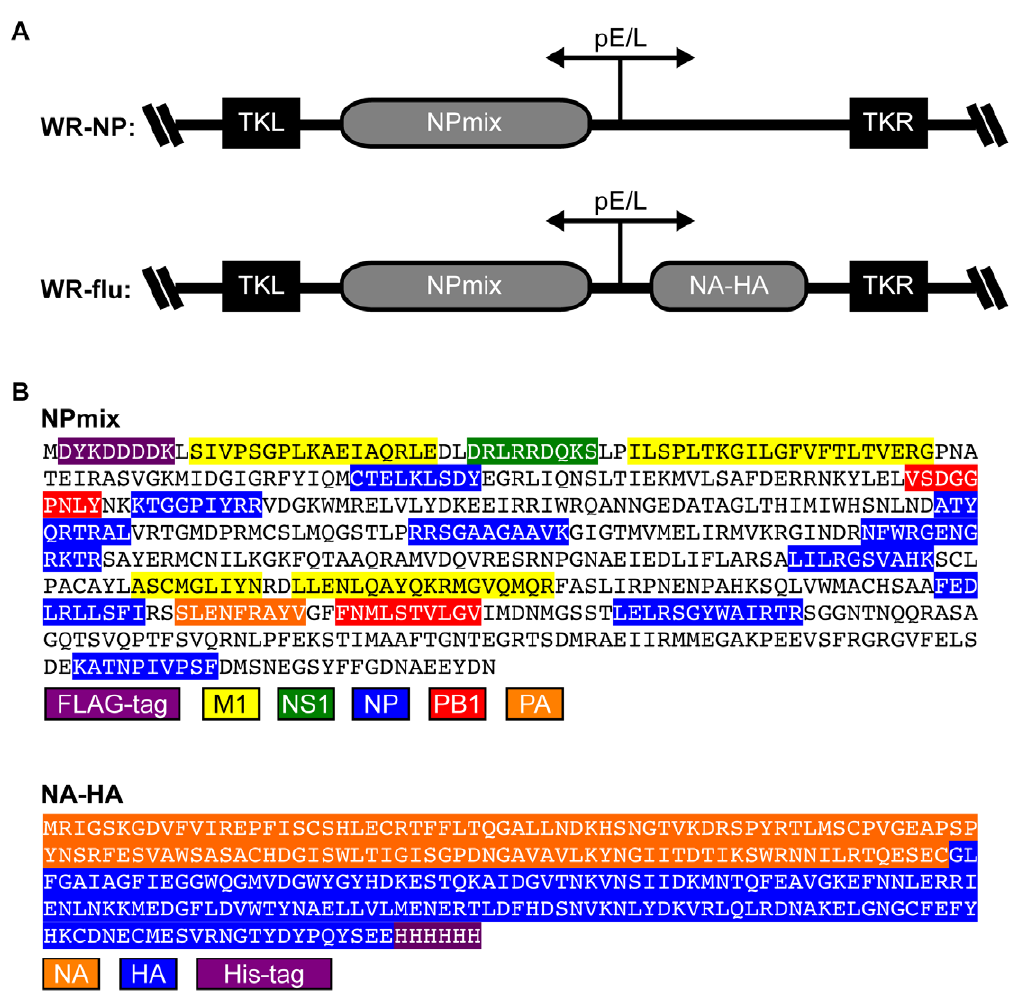
Figure 1. Design and characterization of vaccine constructs. (A) Recombinant influenza virus gene constructs (NPmix or NA-HA) were inserted at the TK locus of the Western Reserve (WR) of vaccinia virus and are driven by the synthetic early/late promoter (pE/L). The cloning vectors (shown) were introduced into the wild-type WR virus by homologous recombination and iterative plaque purification. (B) Amino acid sequences of NPmix and NA-HA recombinant influenza virus protein constructs. The backbone for the NPmix construct is influenza virus NP into which was inserted other influenza virus protein human T cell epitopes. Human T cell epitopes for influenza virus M1, NS1, NP, PB1, and PA proteins are indicated. The NA-HA construct consists of the conserved regions of H5N1 influenza virus neuraminidase (N-terminal amino acids 108–231) and hemagglutinin (C-terminal amino acids 347–511).